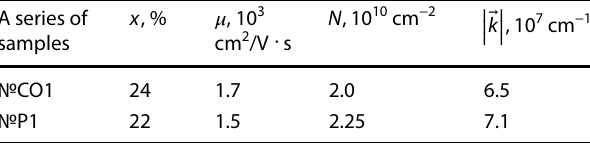
Table 4 Analytical 2DEG data obtained through calculations for a series of heterostructure samples InGaN/AlGaN/GaN A series of